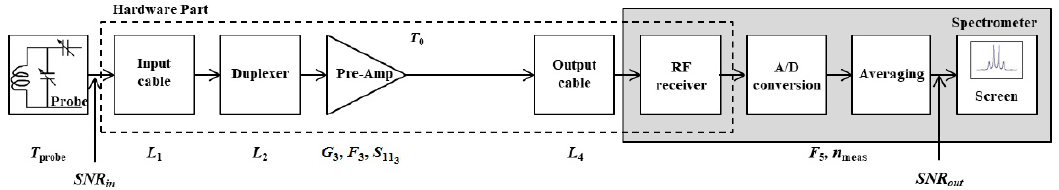
Figure 3. Block diagram of a NMR spectroscopy receiving chain with a single-stage pre-amplifier.